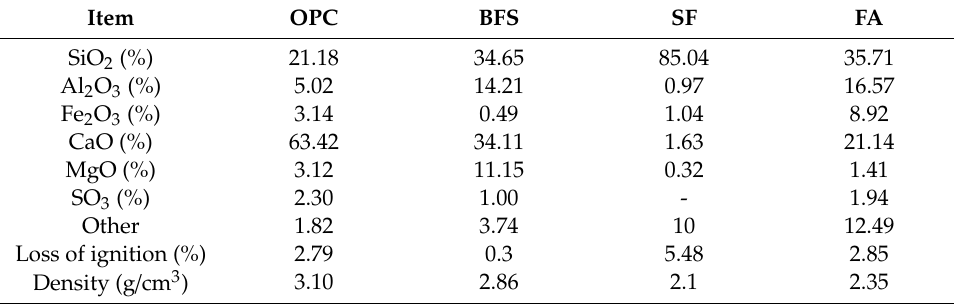
Table 2. Physical and mechanical properties of fibers.